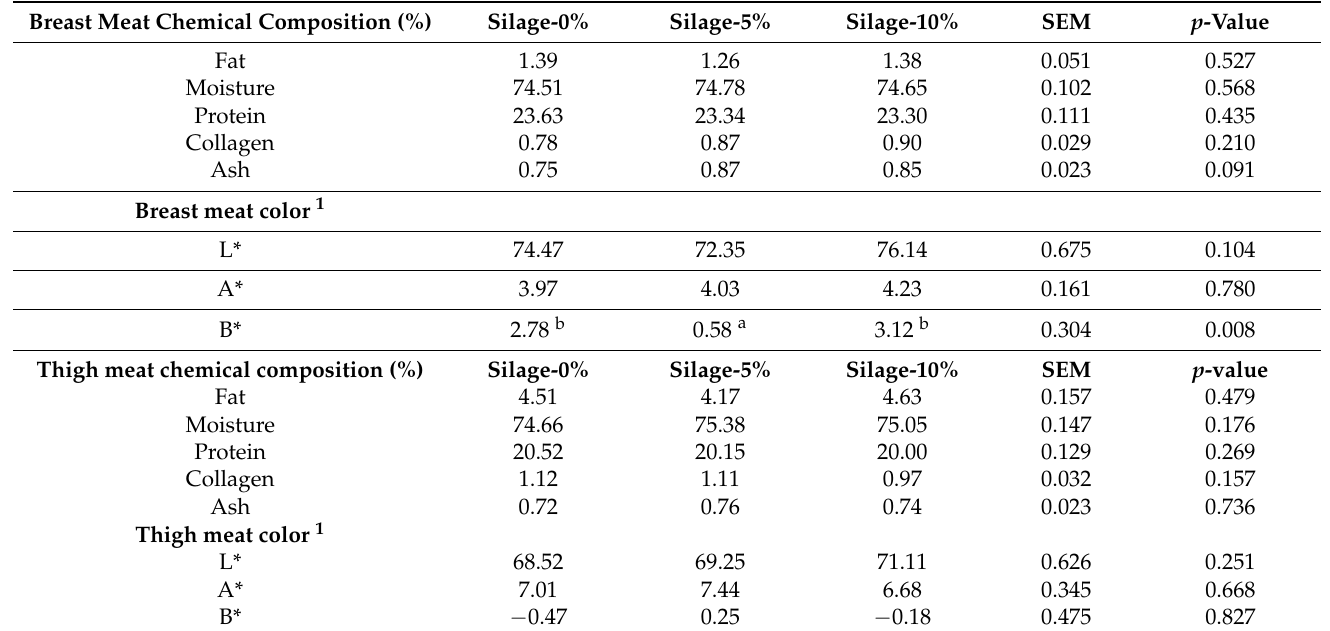
Table 6. Effect of silage supplementation on broiler breast and thigh meat chemical